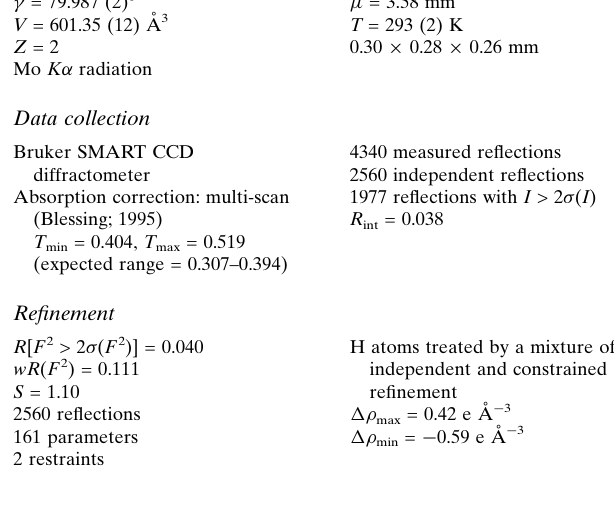
Hydrogen-bond geometry (A˚ , (cid:1)